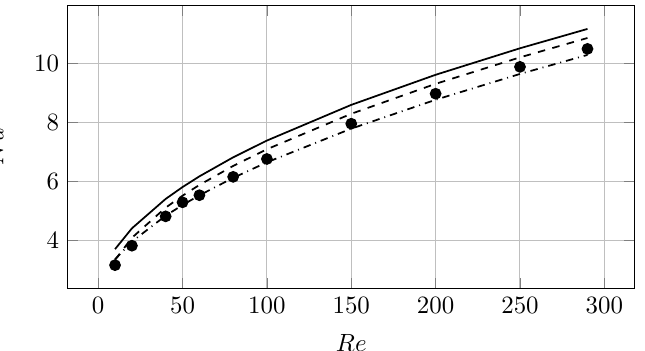
Figure 7. Nusselt coefficient for the uniform flow past a hot sphere at different Reynolds